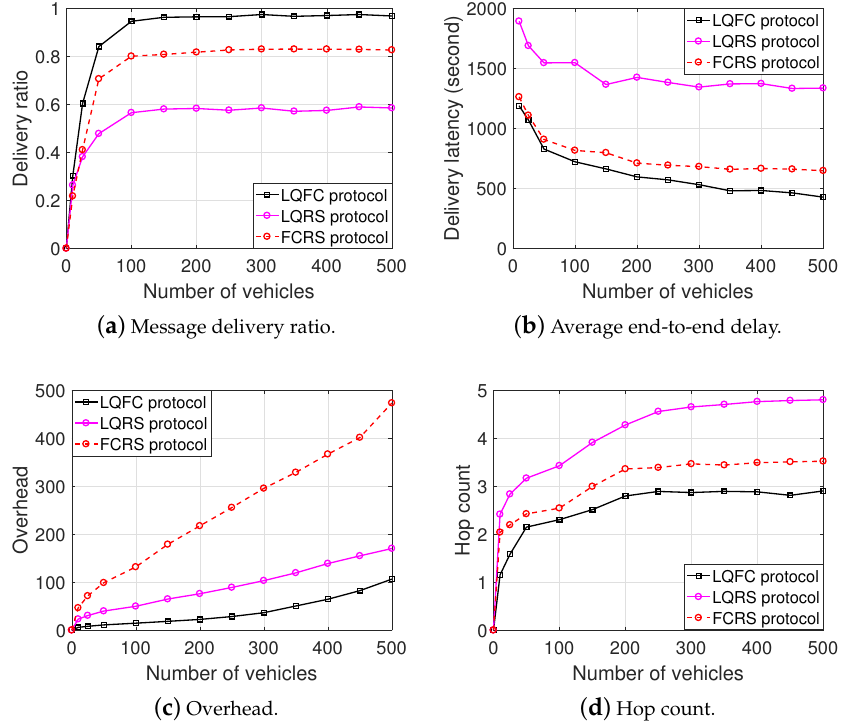
Figure 2. Network performance vs. number of vehicles.